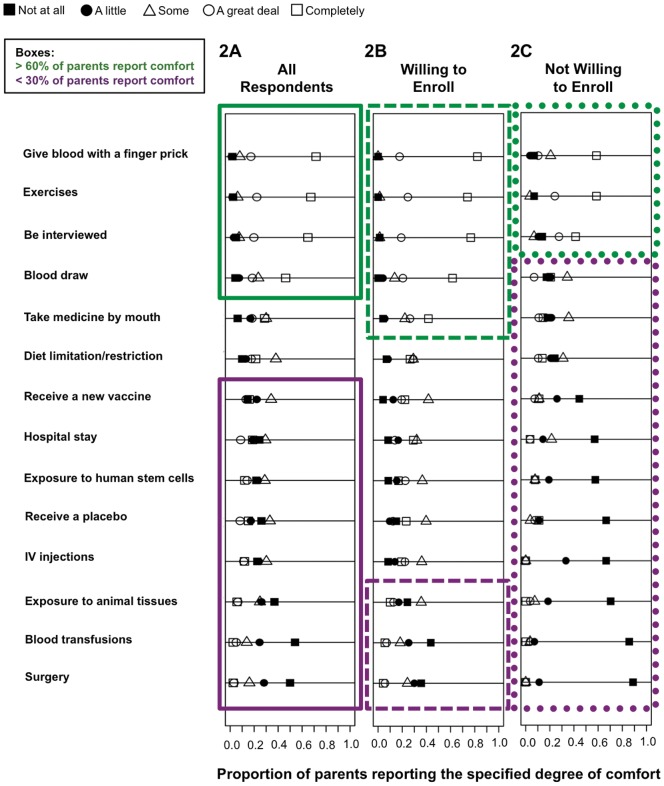
Parental responses to items probing comfort with various clinical trial protocols.Parents were asked: “We would like to know more about how specific tasks that may be part of a Type 1 diabetes clinical trial may influence your decision to enroll your child. How comfortable would you feel if your child were asked to do the following?” Shapes correspond to self-described comfort score on a five-point Likert scale: black square  =  not at all, black circle  =  a little, white triangle  =  some, white circle  =  a great deal, white square  =  completely. The X-axis represents proportion of parents endorsing a specific comfort score. “All Respondents” indicates protocol-specific comfort breakdown for all parents; “Willing to Enroll” indicates protocol-specific comfort breakdown for parents who endorsed they were “completely” or “a great deal” willing to enroll a child with diabetes; “Not Willing to Enroll” indicates protocol-specific comfort breakdown for parents who endorsed they were “not at all” or “a little” willing to enroll a child with diabetes. Breakdown for reponses depending on willingness to enroll an unaffected child are not shown as results are similar. Green box highlights tasks with which >60% of all parents were “a great deal” or “completely” comfortable. The purple box highlights tasks with which <30% of all parents were “a great deal” or “completely” comfortable. Comfort with all protocols surveyed had a statistically significant positive correlation with both willingness to enroll a child with diabetes and a non-affected child (r = 0.23–0.6). This effect can be appreciated above by the larger green and much smaller purple box among parents who reported willingness to enroll their children in T1DCTs.